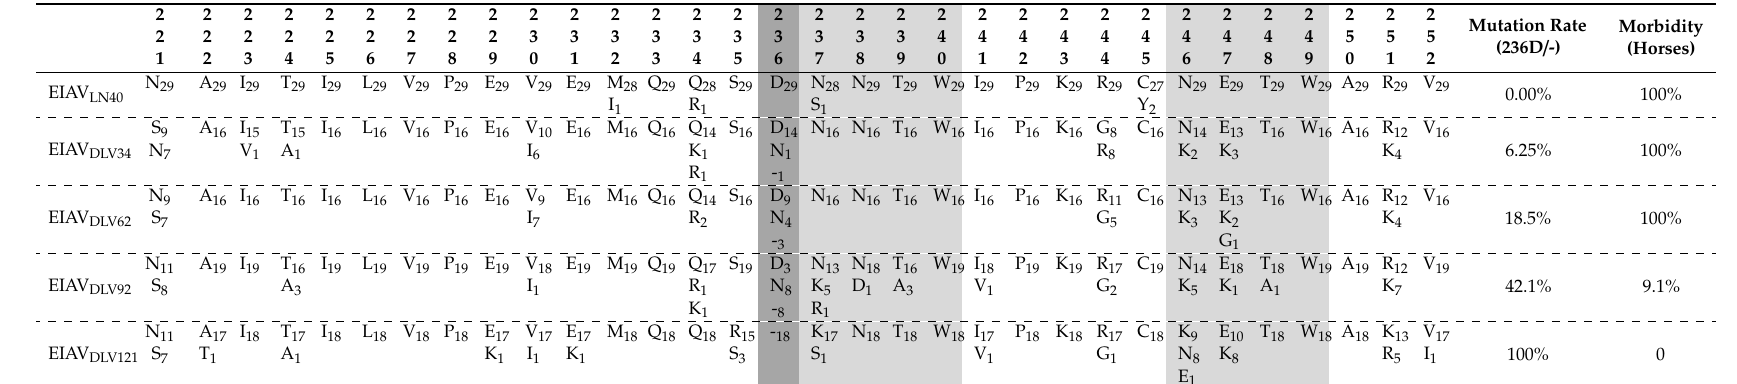
The additional amino acid D, which consistently appeared in virulent EIAV strains, is marked with dark grey, and N-linked glycosylation sites are marked with light